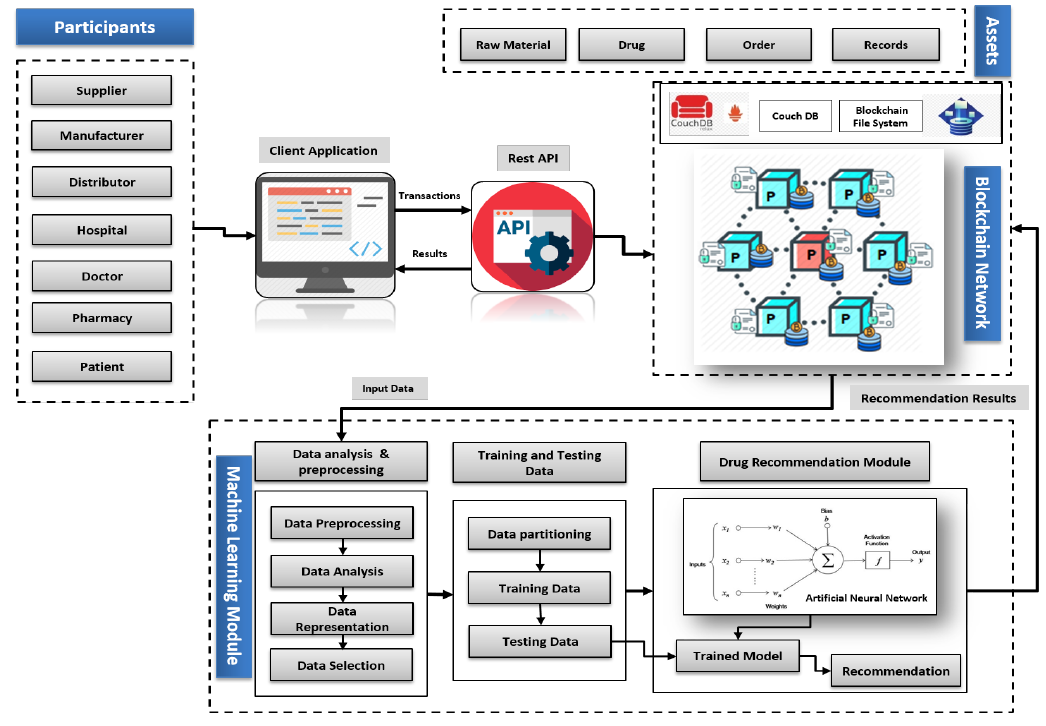
Figure 2. Detailed architecture of DSCMR